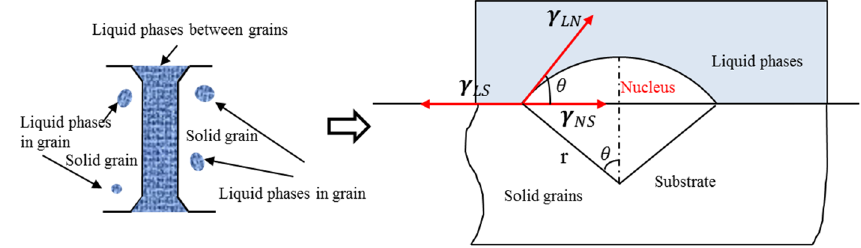
Figure 6. Principle of liquid phase heterogeneous nucleation.